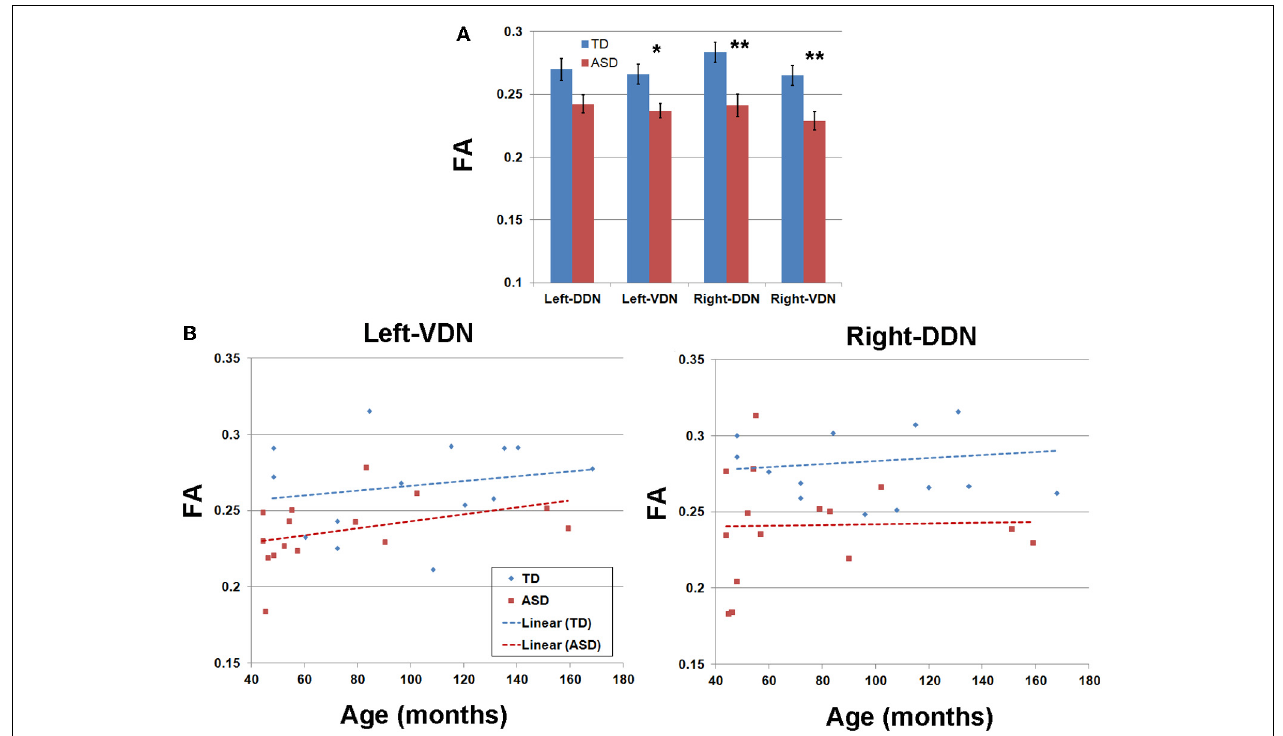
FA values and ages of individual subjects obtained from left VDN pathway (left) and right DDN pathway (right) showing the most significant group